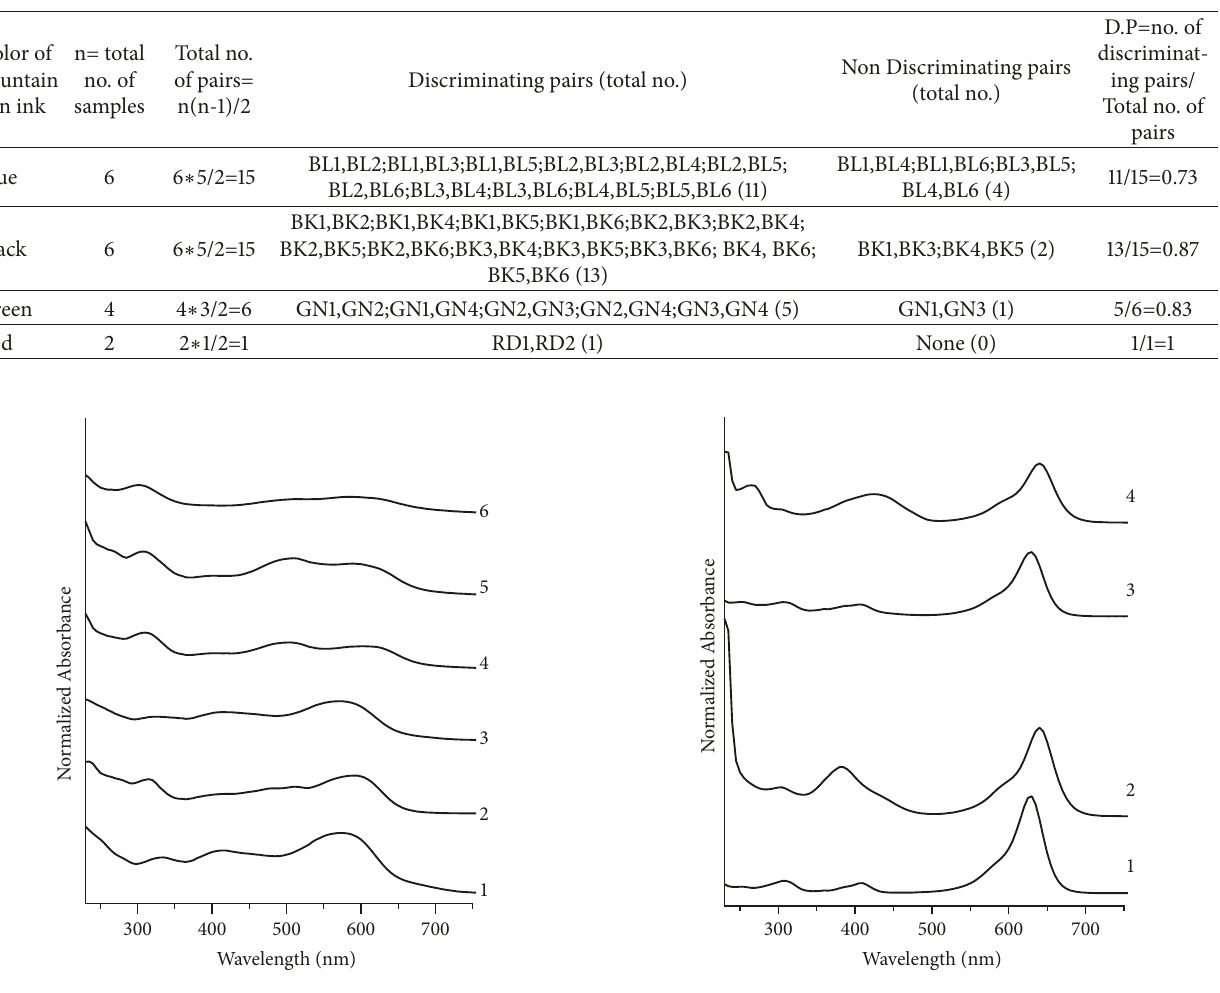
Figure 2: Normalized UV/Visible absorption spectra for black fountain pen inks. 1, 2, 3, 4, 5, and 6 represent samples no. BK1, BK2, BK3, BK4, BK5, and BK6, respectively.